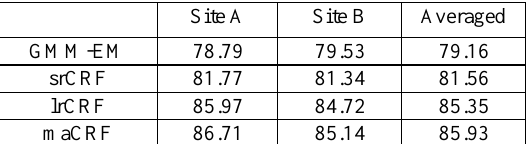
Tabel 2. The overall classification accuracy of four methods.